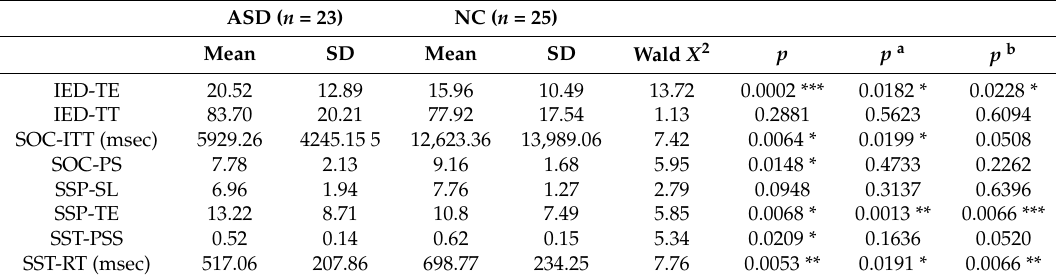
Table 2. Group differences in executive